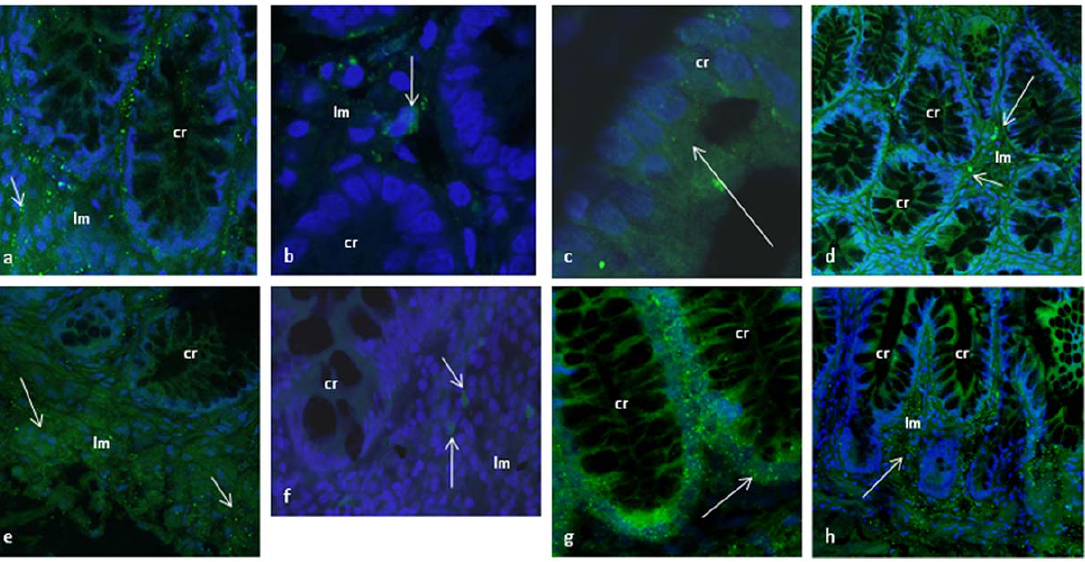
Figure 4. Identification of EP receptors in normal human intestine by immunhistochemistry. a – b) Anti-EP1 antibody detects positive cells in the lamina propria in both colon (a) and small intestinal tissue. No expression is found in crypts. (b), c – d) Anti-EP2 antibody detects positive cells in colon crypts (c), but not in small intestine crypts where EP2 expression is detected in lamina propria only (d), e – f) Anti-EP3 antibody detects positive cells in the lamina propria in both colon (e) and small intestinal tissue (f). No expression is found in crypts, g – h) Anti-EP4 antibody detects positive cells in colon crypts (g), but not in small intestine crypts where EP4 expression is detected in lamina propria only. Nuclei are stained with Hoechst